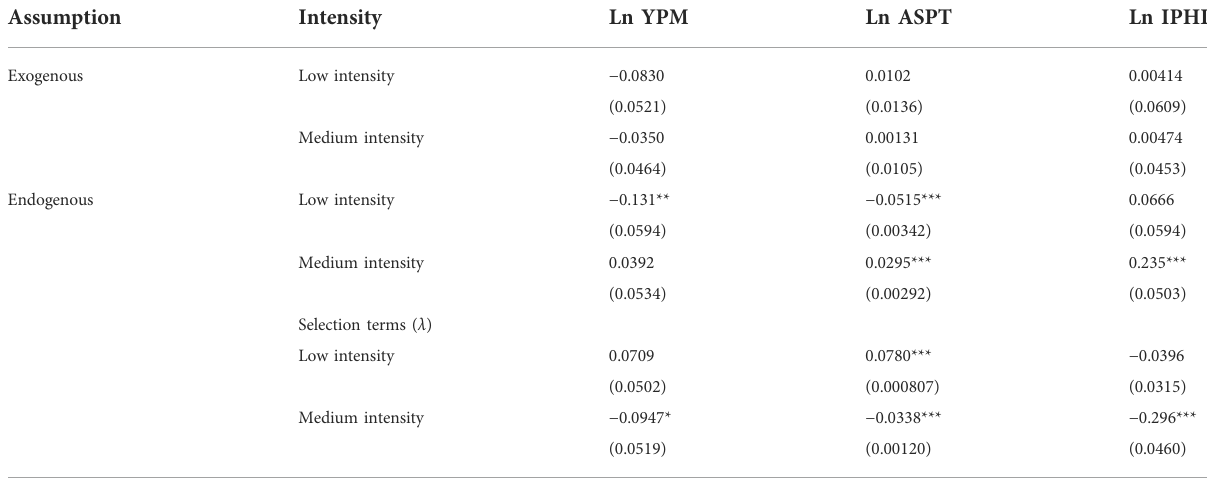
TABLE5METE modelestimationoftheimpactofdifferent adoptionintensitiesonthetobaccoyieldandhouseholdincomeinChongqing, China(the baseline is high intensity).